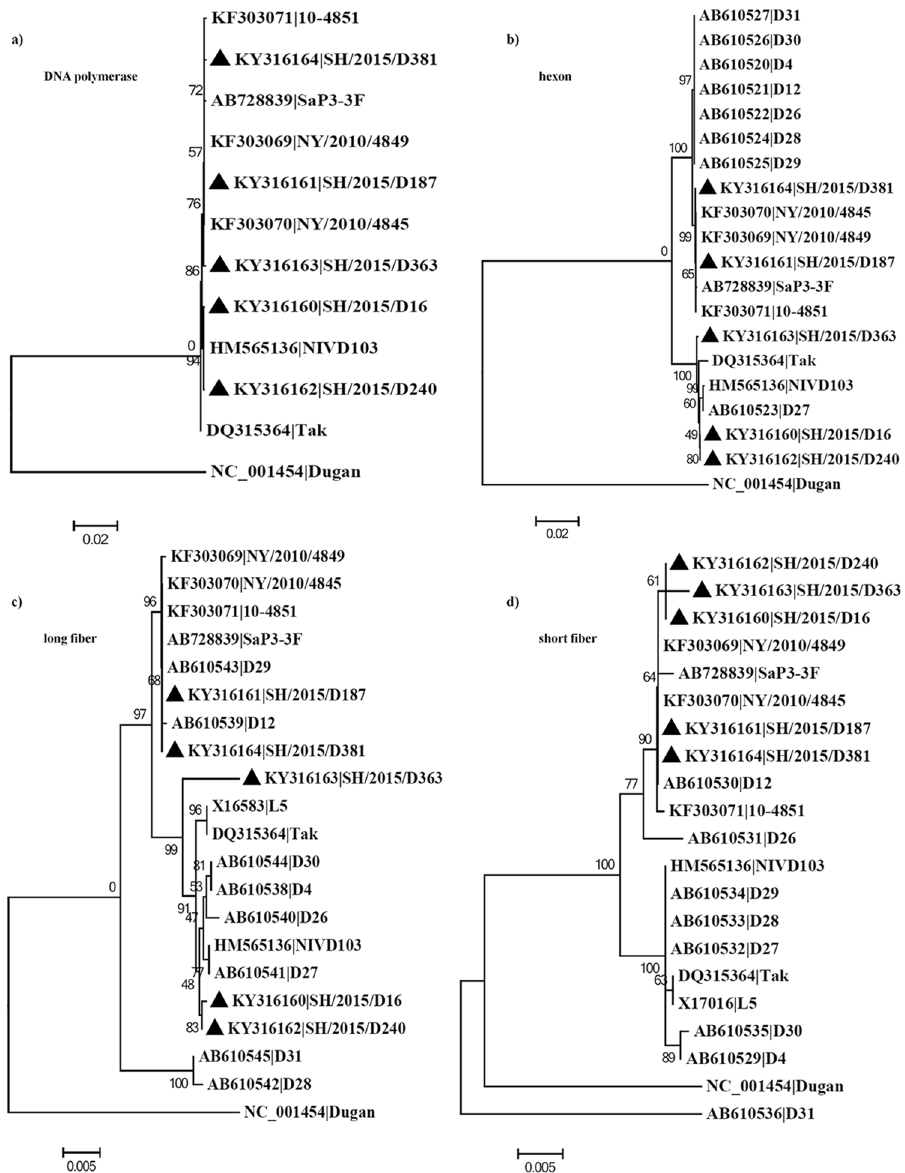
Figure 4. The Neighbor-Joining phylogenetic tree showing relationship of five isolates in this study to other adenoviruses inferred from ( a ) DNA polymerase, ( b ) hexon gene, ( c ) long fiber gene, and ( d ) short fiber